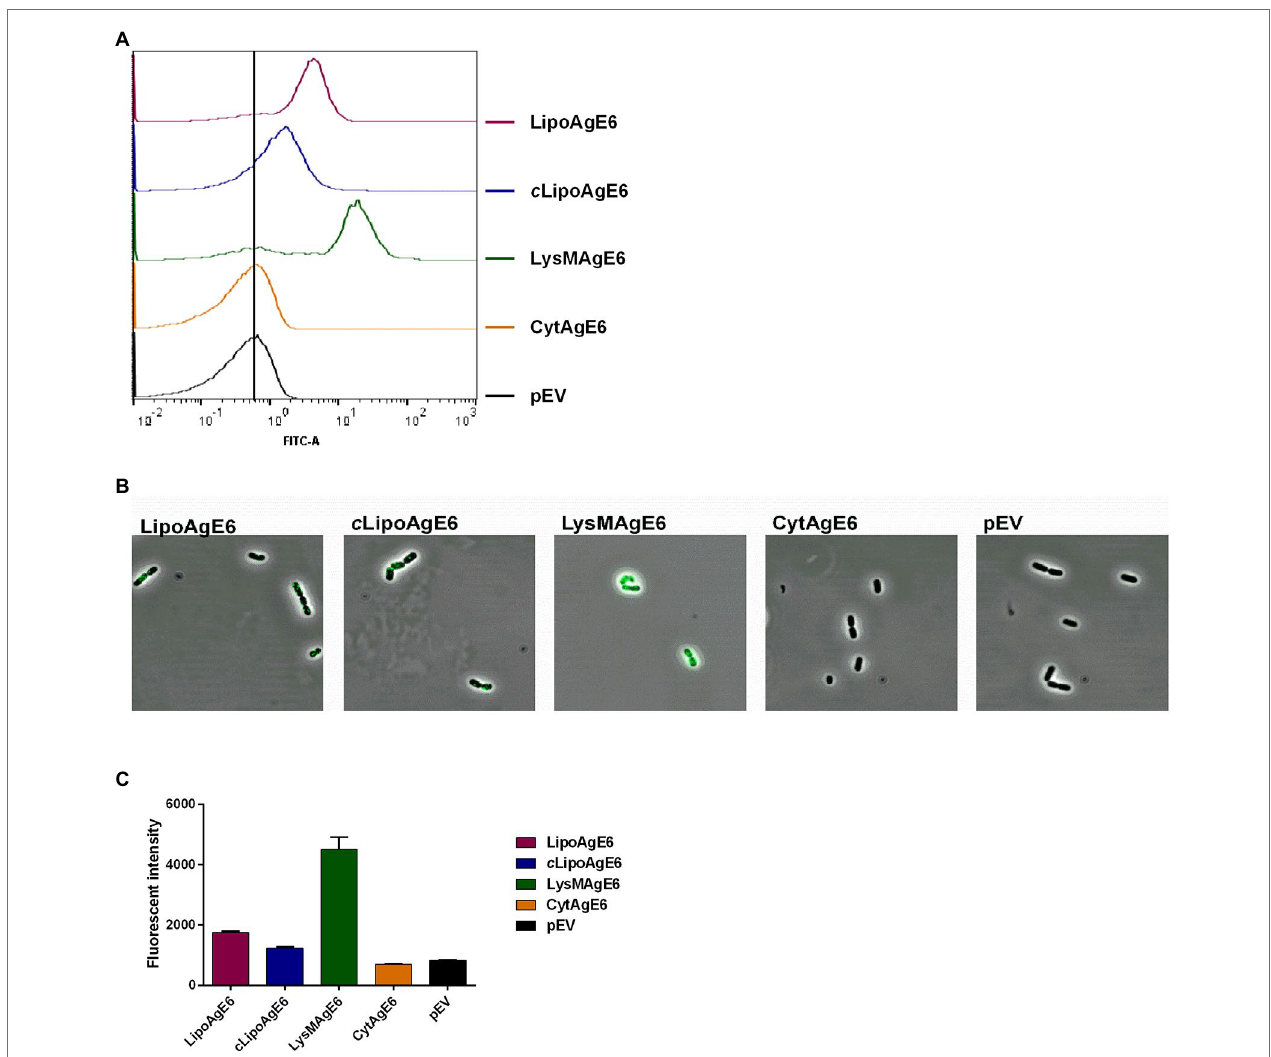
FIGURE 4 | Analysis of surface display of Ag85B-ESAT6-DC (AgE6) by flow cytometry (A) and indirect immunofluorescence microscopy (B) . Panel C shows a bar chart for comparison of fluorescent intensity of the FITC signal for the various strains as derived from the image analysis. The number of bacteria analyzed for evaluation of FITC signal were 215 for LipoAgE6, 93 for cLipoAgE6, 120 for LysMAgE6, 50 for CytAgE6, and 141 for pEV. The data are from one representative experiment out of at least three experiments. The error bars show the standard